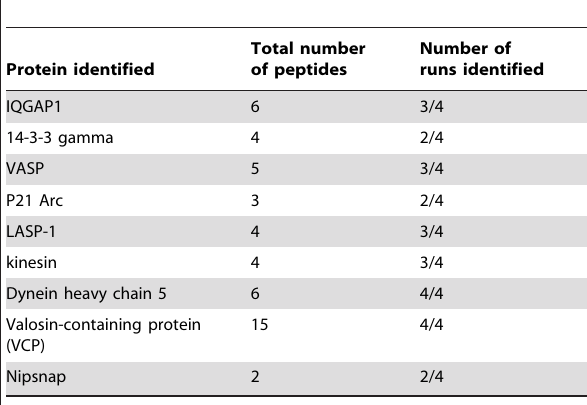
Table 1. Associating CXCR2 proteins identified with proteomics.